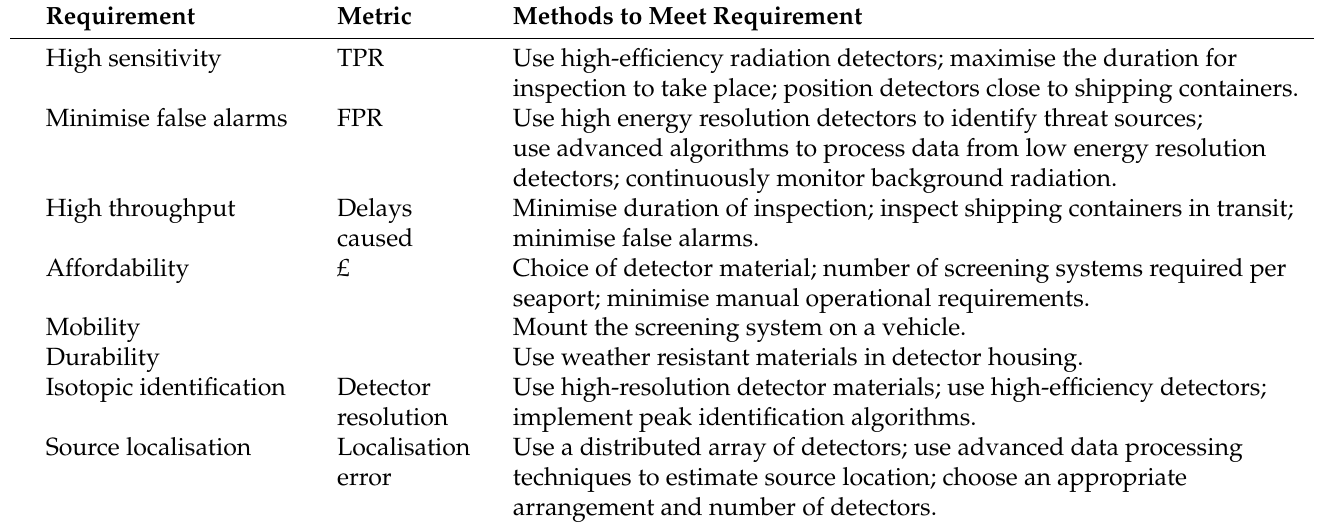
Table 2. Requirements of shipping container screening systems for detecting illicit radioactive or nuclear